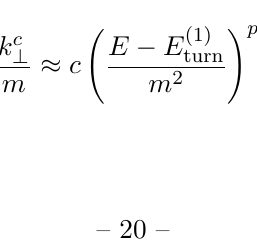
Figure 16 . k c /m as functions of ( E − E (1) ) /m 2 at various temperatures. Both the vertical and turn ⊥ horizontal axes are shown in log scale. The black line shows y ∝ x 1 / 4 for